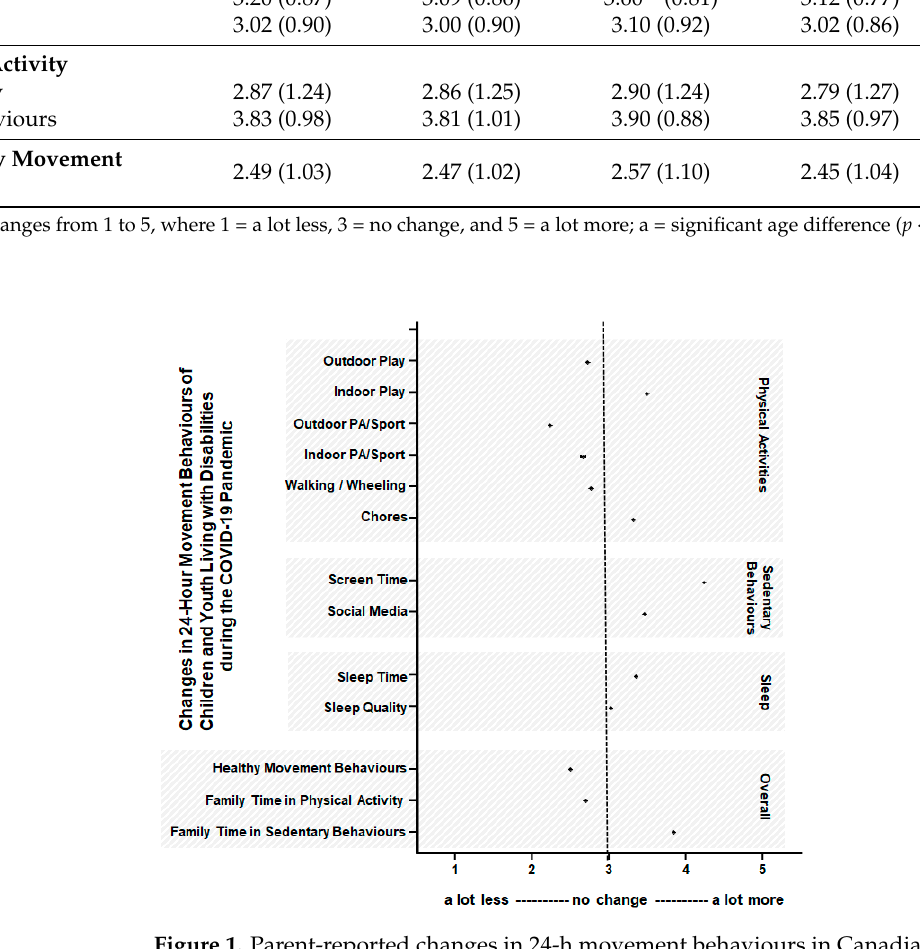
Figure 1. Parent-reported changes in 24-h movement behaviours in Canadian children and youth (5 to 17 years) living with disabilities (CYWD) during the COVID-19 pandemic (May 2020). Scores are based on a 5-point scale range from ‘a lot less’ (score 1) to ‘about the same’ (score 3) to a lot more (score 5). See Tables 2 and 3 for more details. Data points are means with standard error bars (too small to be